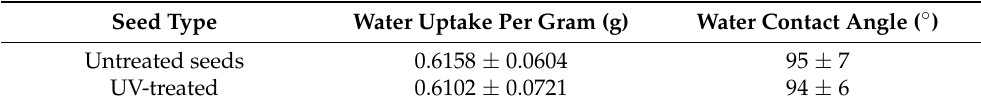
Table 1. Effect of UV radiation on the water contact angle and water uptake of Bambara groundnut